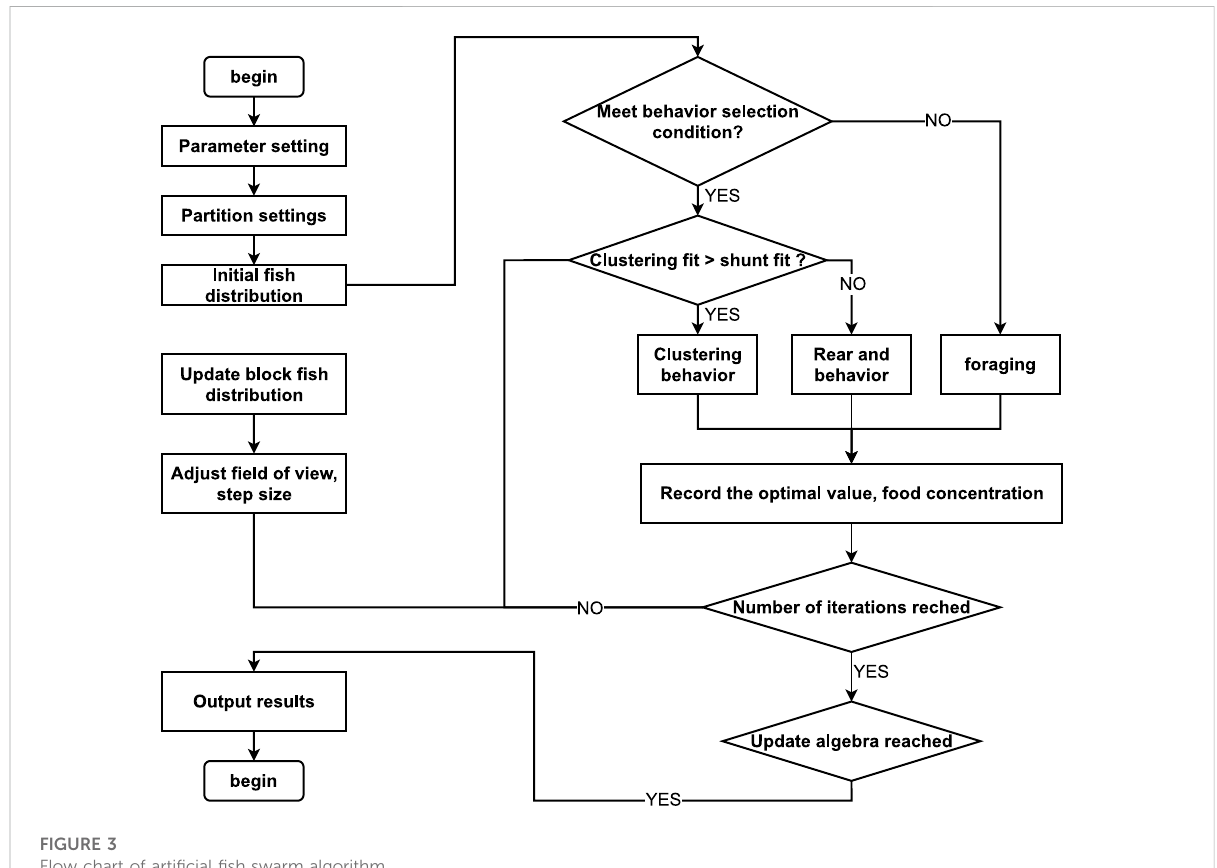
FIGURE 3 Flow chart of arti fi cial fi sh swarm